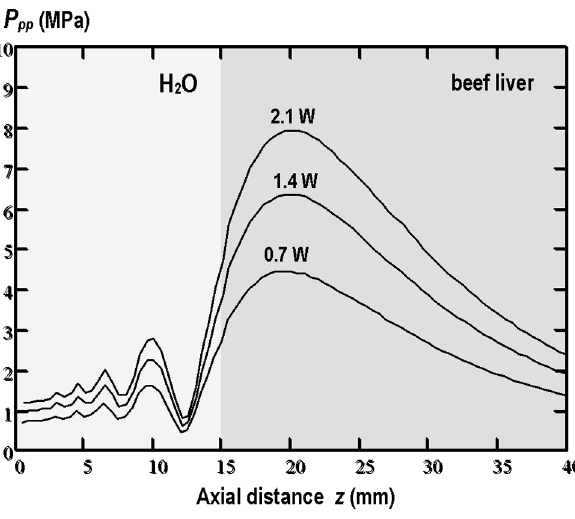
Figure 6. The temperature-time rise induced in the two-layer system of media. : 15 mm water/25 mm beef liver by the pulsed focused nonlinear beam with the average acoustic power of 0.7 W. The measurement data (points) and numerical simulation results (solid lines) at the point of maximum heating ( z =20 mm) for the assumed thermal conductivity of the beef liver varied between 0.48 W/(m ? u C) and